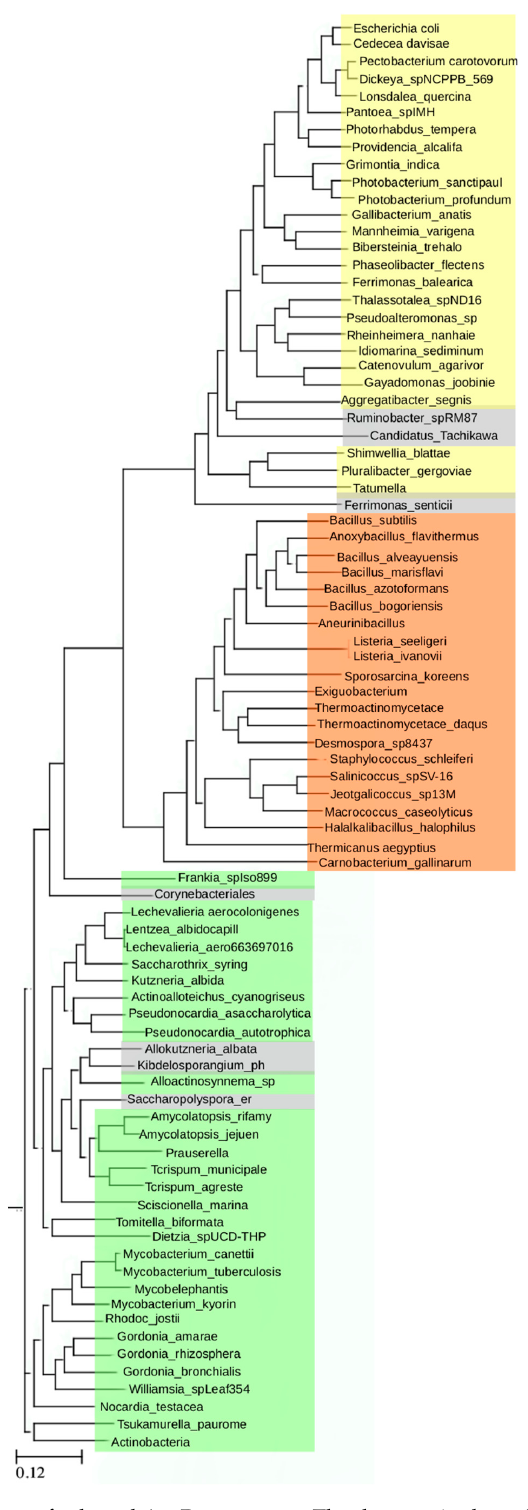
Figure 2. Phylogenetic tree of selected ArgR sequences. The three major branches are colored: green is defined by MtArgR and is closest in evolutionary distance to the common ancestor (scale bar, bottom, average number of residue substitutions per position); orange is defined by BsArgR; and yellow is defined by EcArgR. Entries shown in grey represent sequences that belong to the assigned phylogenetic group but lack the corresponding sequence